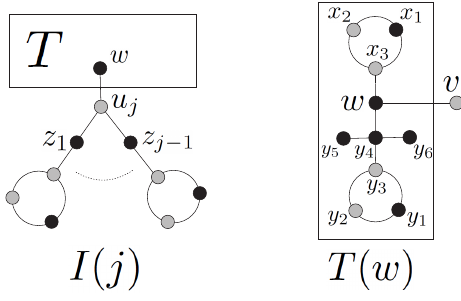
Fig. 1: The auxiliary graphs I ( j ) and T ( w )